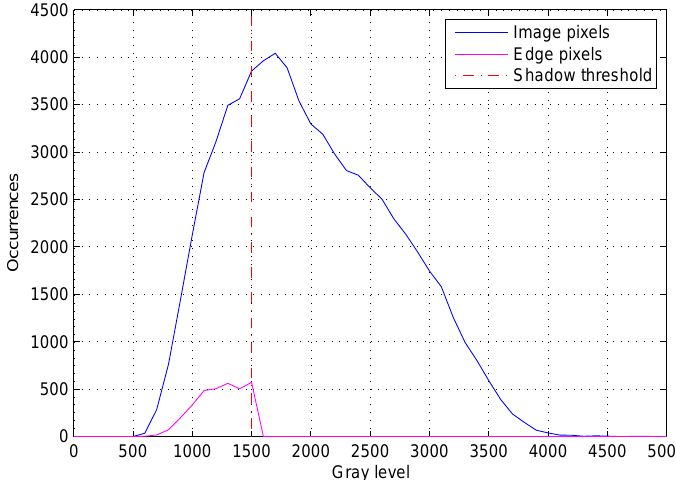
Figure 8. The distribution of gray-scale